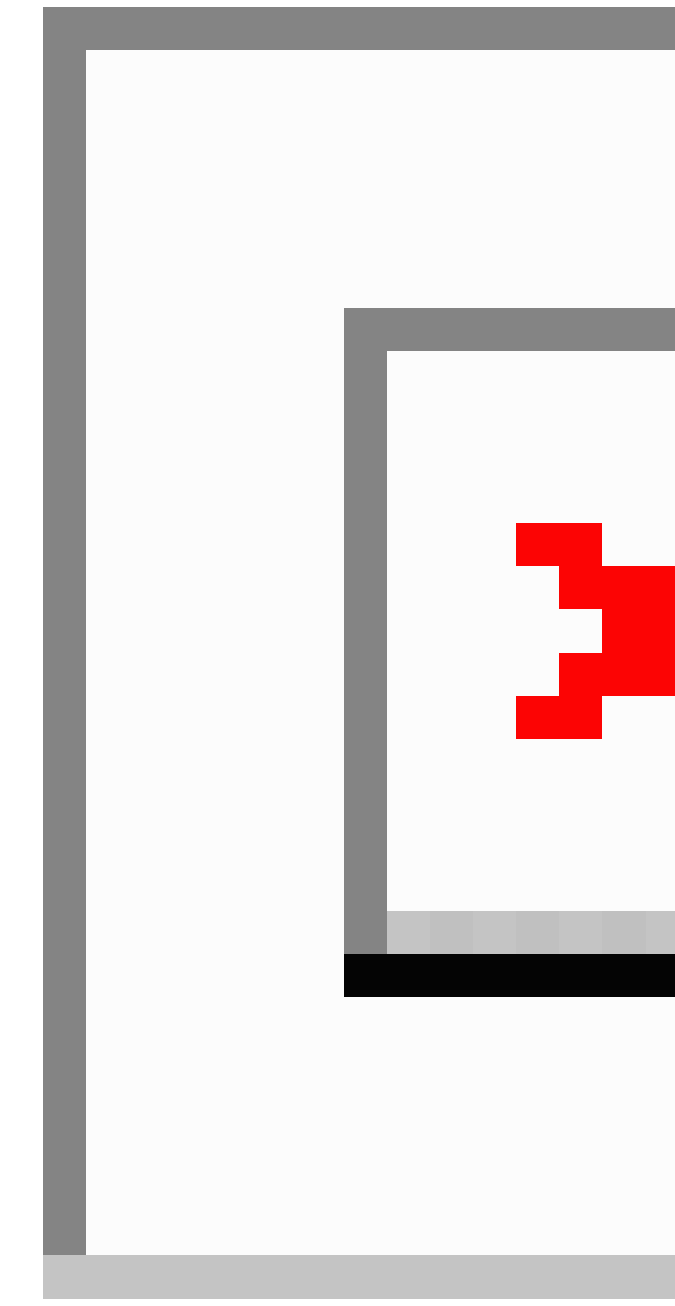
Figure 3. Screenshots of the graphic-based spaced retrieval